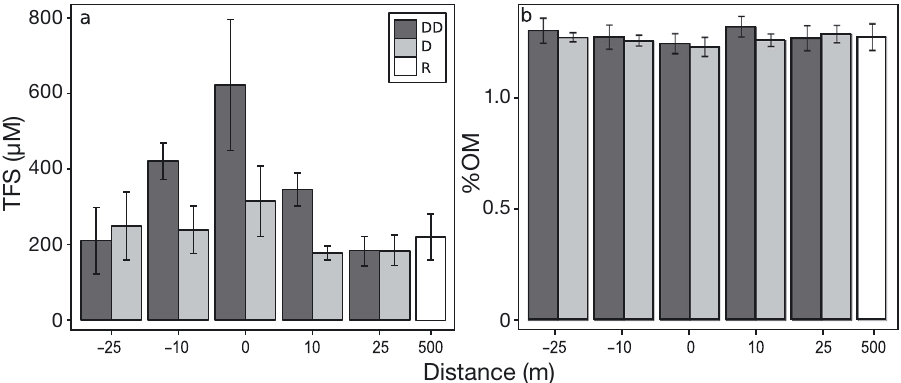
Fig. 4. Mean (±SE) (a) total free sulfide concentrations (TFS) and (b) sediment organic matter content (%OM) recorded in August 2013 under double density (DD) and standard density (D) mussel longlines and at reference stations